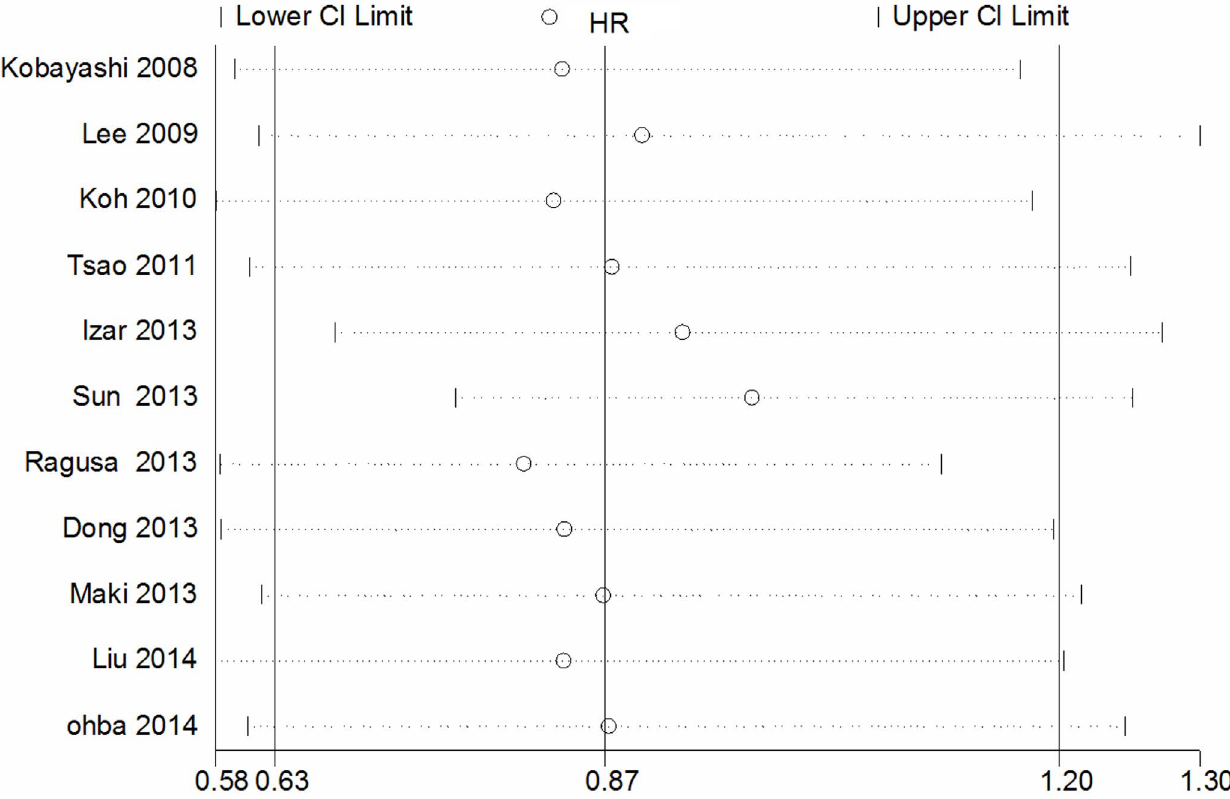
Figure 2. Sensitivity analysis for combined HRs evaluating EGFR mutations on disease free survival.